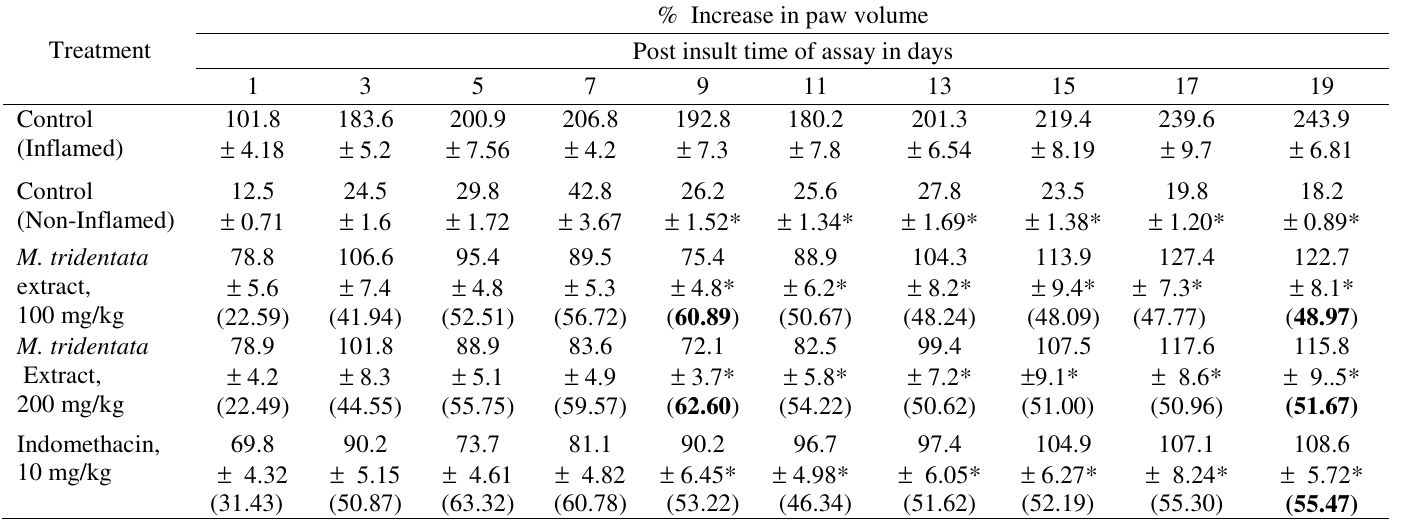
Table 3 . Anti-arthritic activity of ethanol extract of M. tridentata against Freund’s adjuvant induced